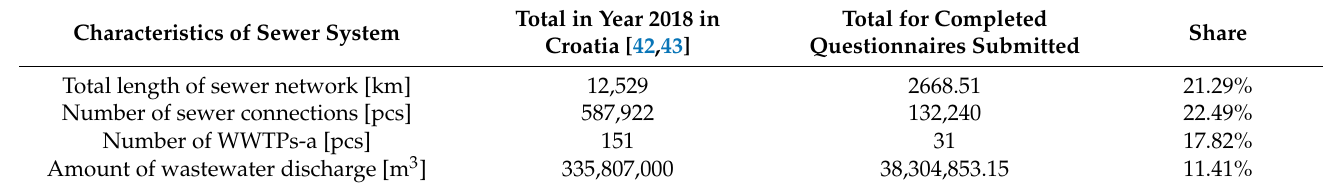
Table 3. Data on the scope of the conducted